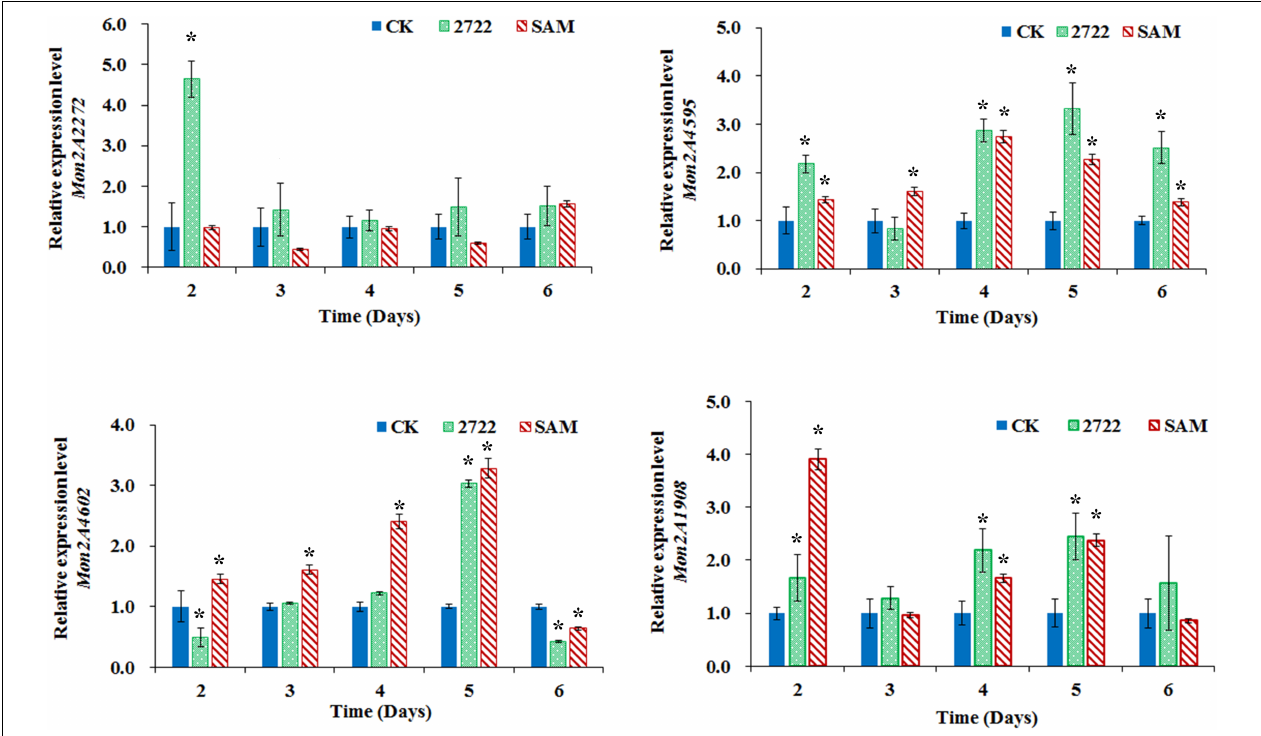
FIGURE 6 | Gene transcriptional level assay in M. purpureus RP2 and M. purpureus 2272. CK, M. purpureus RP2 fermentation without addition of amino acid; 2272, M. purpureus 2272 fermentation without addition of amino acid; SAM, M. purpureus RP2 fermentation with the addition of 1 g/L SAM; Bars with an asterisk are significantly different ( p <